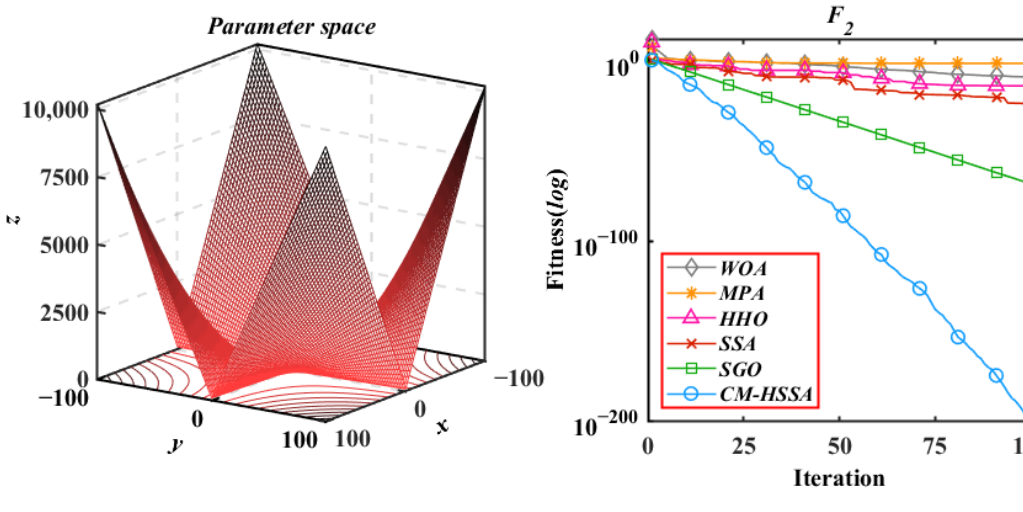
Figure 10. Sphere Model.